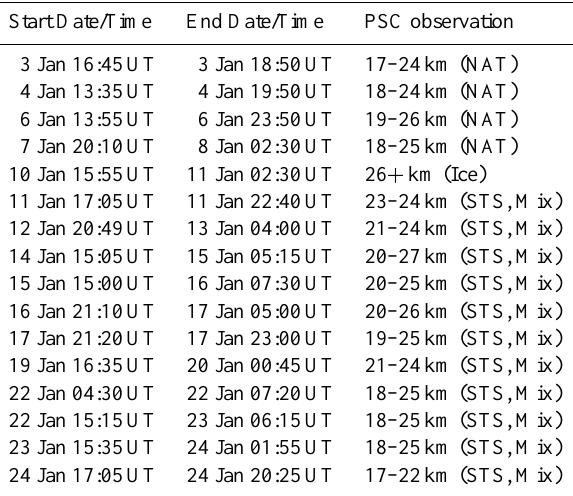
Table 2. PSC observations with the IRF lidar during January 2010.